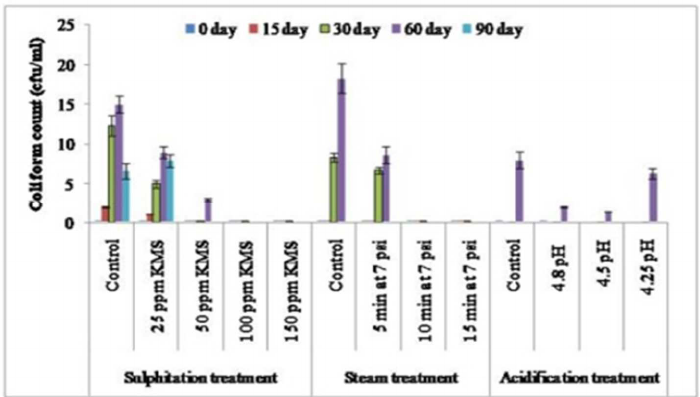
Figure 2. Effect of sulphitation, steam treatment, and acidification on thecoliform countduring storage of sugarcane juice at refrigerator temperature.